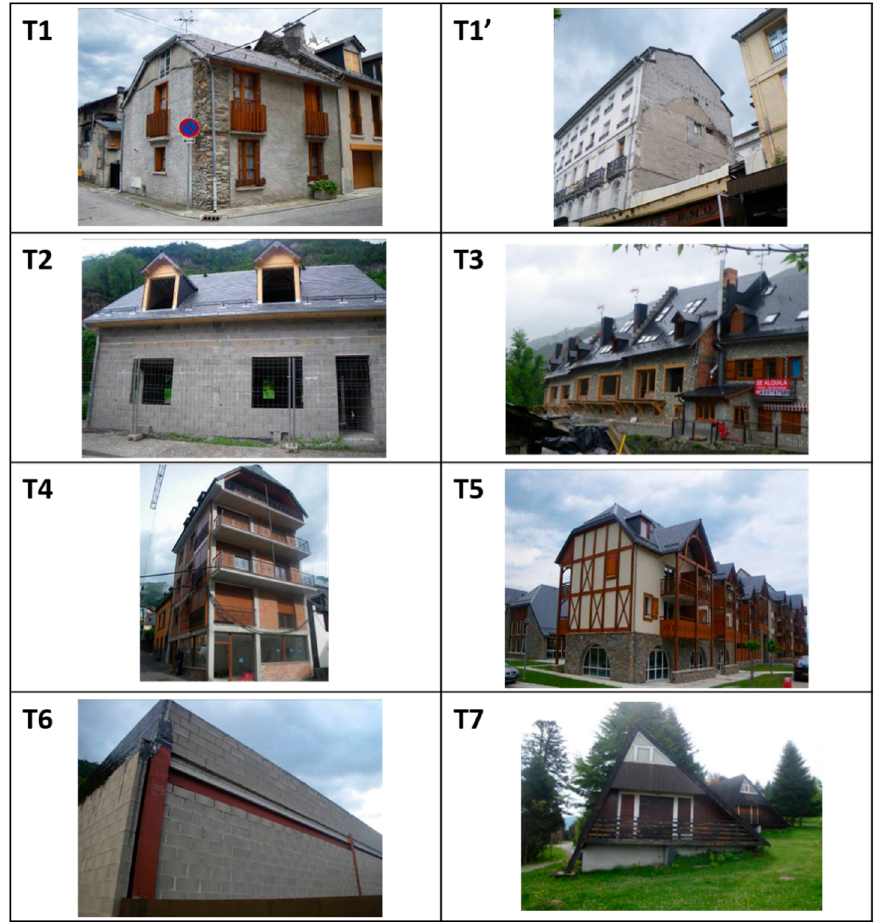
Figure A1. Examples of the main building types found in Bagnères-de-Luchon sector.